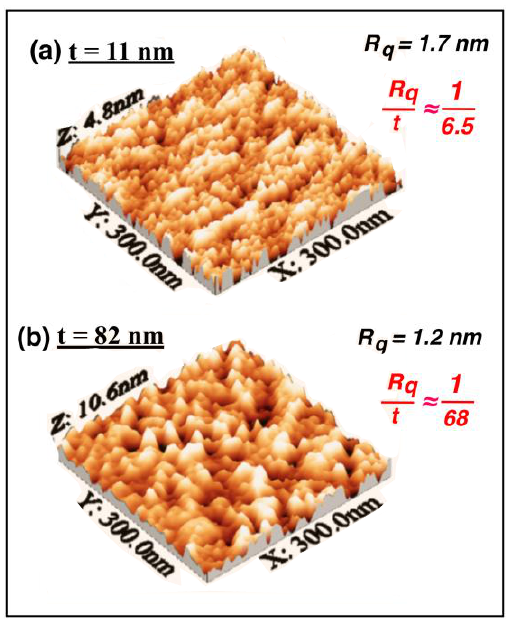
Figure 8. Some representative STM images corresponding to two different films, ( a ) t = 11 nm and ( b ) t = 82 nm. The surface roughness R q , the root mean square of the surface roughness, was similar for both, and R q / t ≈ 1/6.5 at t = 11 nm, R q / t ≈ 1/68 at t = 82 nm.